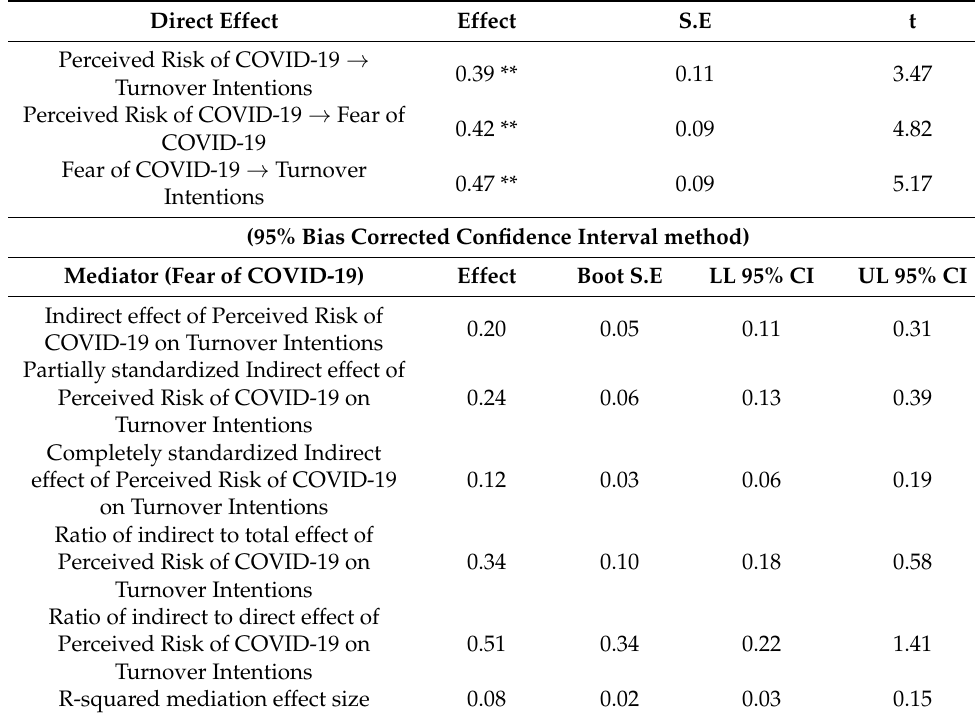
Table 5. Bootstrapping results for direct and indirect